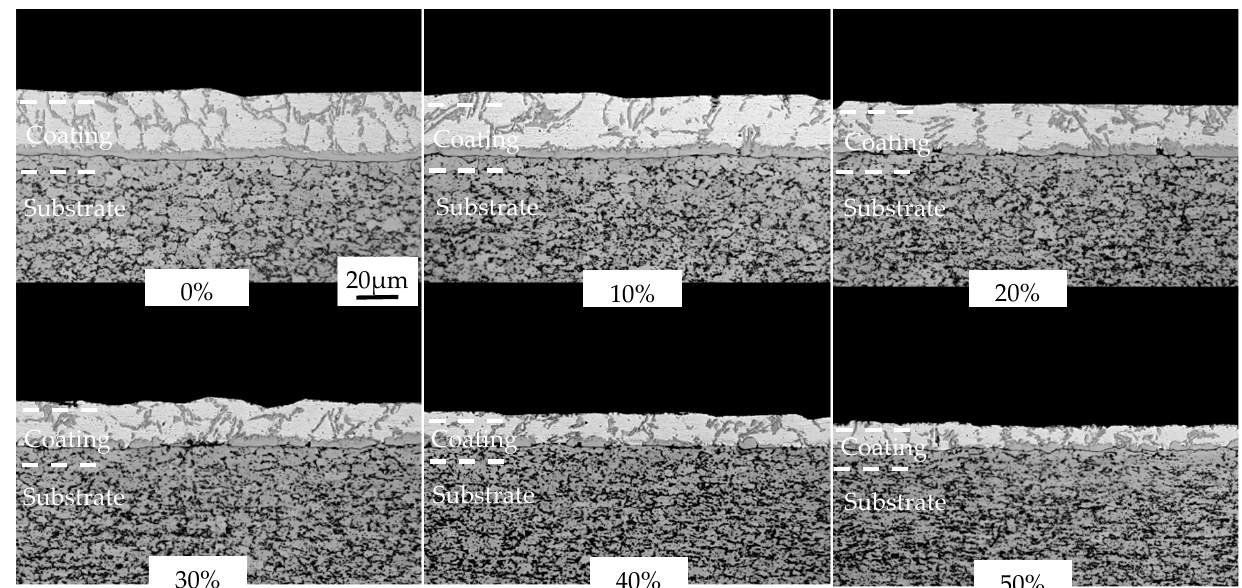
Figure 3. Optical microscopy ( OM) micrographs of AS60/60 coating at different reduction ratios.